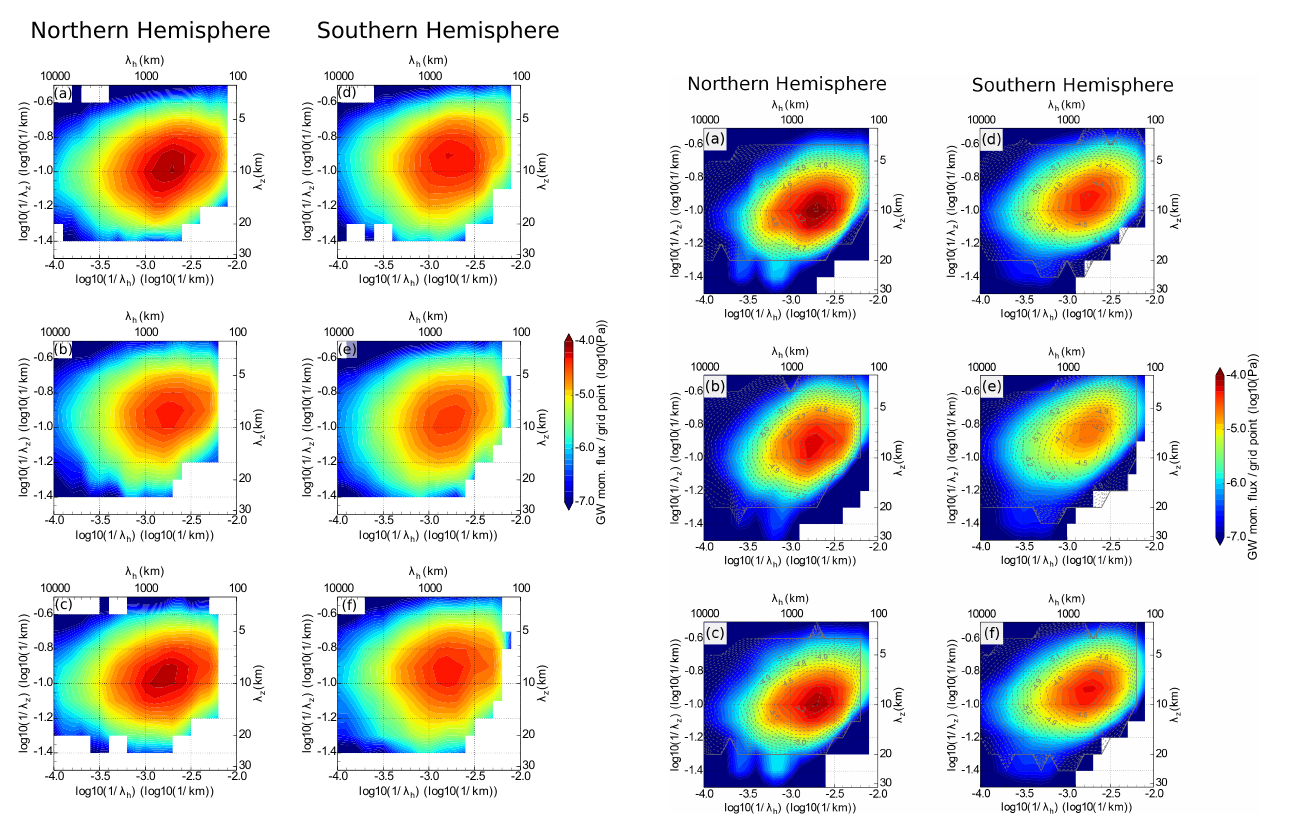
Figure A3. Filtered simulated GWMF spectra for different hemi- spheres for 3 consecutive years. Panels (a, b, c) show spectra for July 2005, 2006, 2007 respectively; panels (d, e, f) show spectra for January 2006, 2007, 2008. All spectra are averaged over three regions of deep convection of each hemisphere as shown in Fig. 2